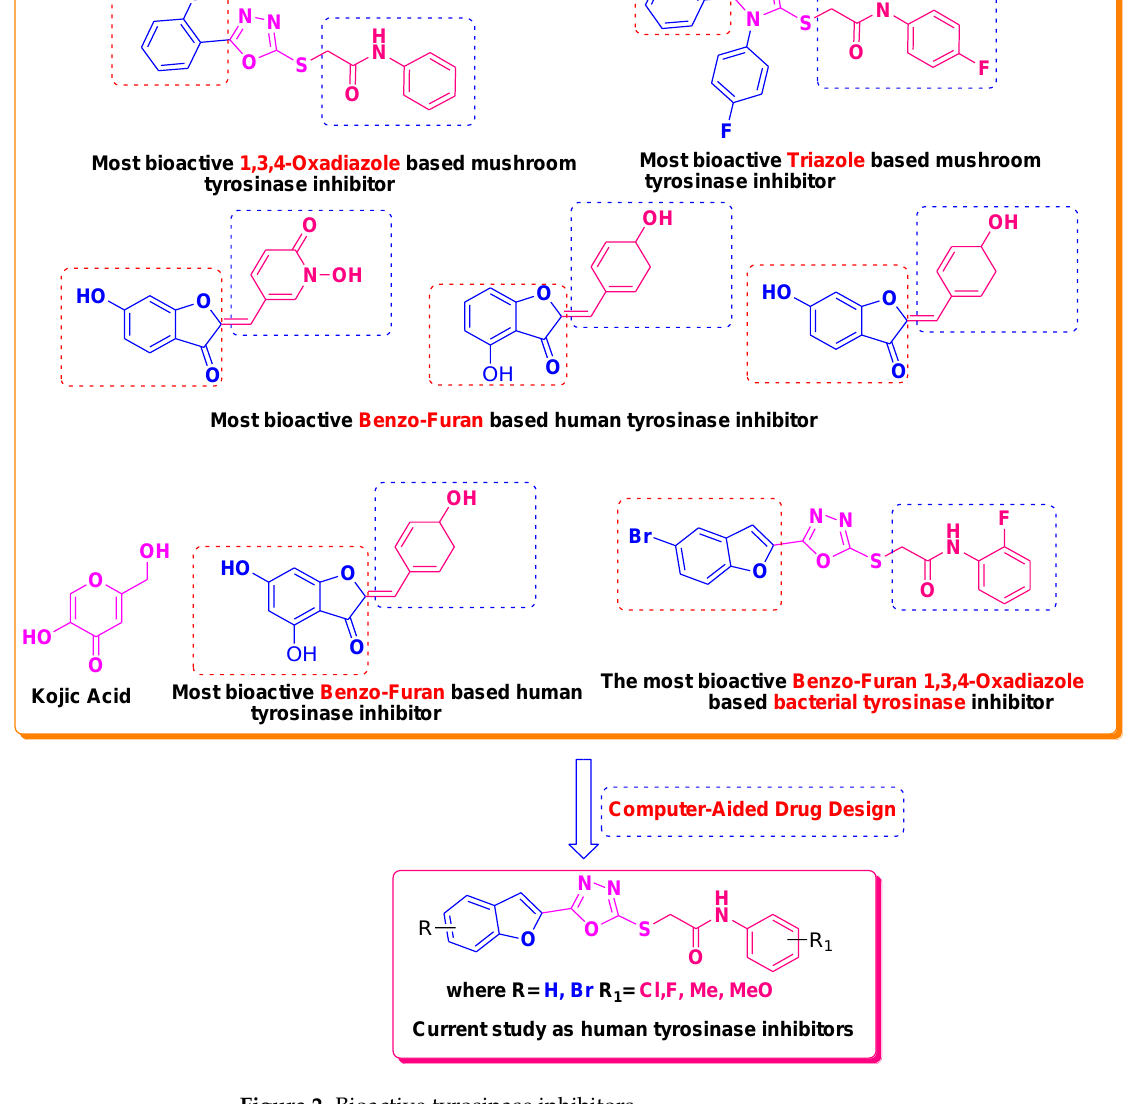
Figure 2. Bioactive tyrosinase inhibitors.